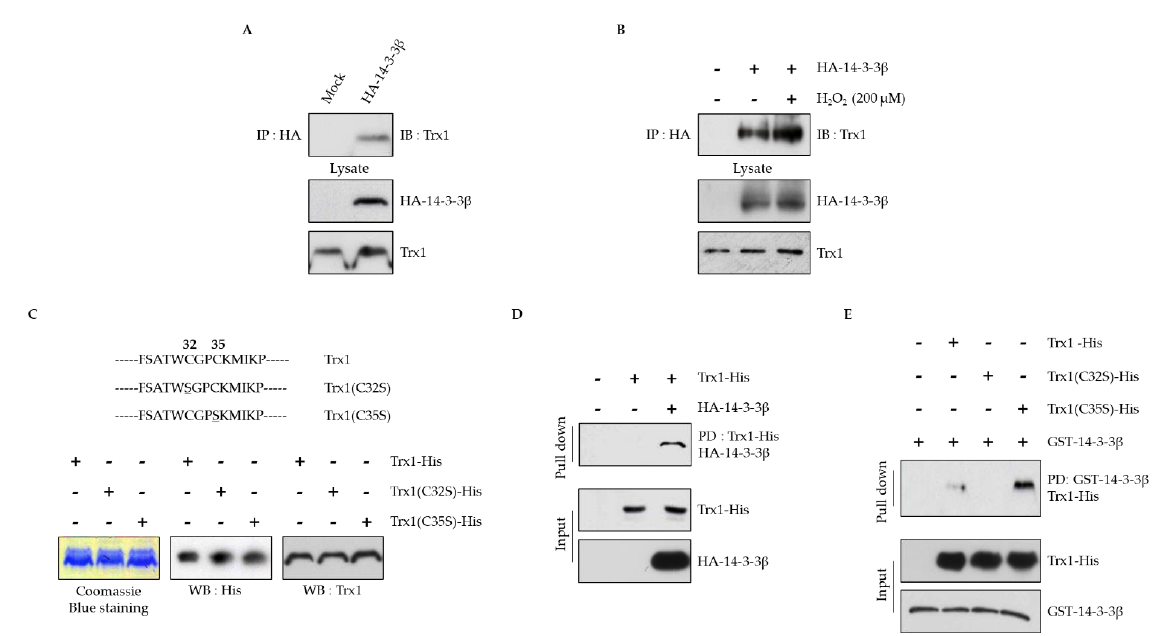
Figure 1. Trx1 interacts with 14-3-3 β . ( A ) Human embryonic kidney 293 (HEK293) cells were transfected with HA-14-3-3 β , and the cells were harvested 24 h after transfection. The cell extracts were immunoprecipitated with anti-HA antibody and then immunoblotted with anti-Trx1 antibody. ( B ) HEK293 cells were transfected with HA-14-3-3 β for 24 h and then treated with H 2 O 2 (200 µ M) for 30 min. The cell extracts were immunoprecipitated with anti-HA antibody and then immunoblotted with anti-Trx1 antibody. ( C ) Sequences of mutant Trx1. The underlines and numbers indicate the mutation sites. Trx1-His, Trx1(C32S)-His, and Trx1(C35S)-His proteins were purified and verified by Coomassie staining (left) and immunoblotting with anti-His (middle) and anti-Trx1 (right) antibodies. ( D ) Purified Trx1-His protein was incubated with HEK293 cell lysates overexpressing HA-14-3-3 β for 1 h. The mixtures were incubated with Ni-NTA beads for 1 h and then immunoblotted with anti-HA or anti-His antibodies. ( E ) Each purified Trx1-His, Trx1(C32S)-His, and Trx1(C35S)-His protein was incubated with purified GST-14-3-3 β . The mixtures were incubated with glutathione beads for 1 h and then immunoblotted with anti-His or anti-GST antibodies. The data were obtained from three independent